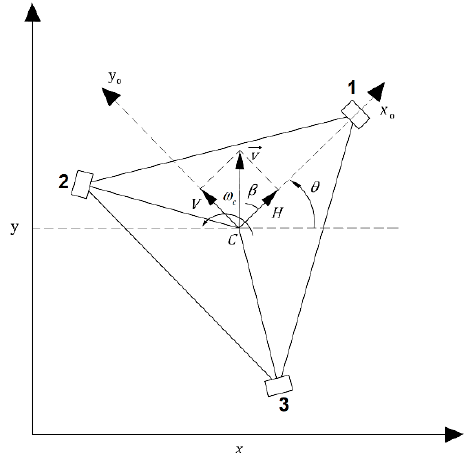
Figure 2. Configuration of velocity vector of the omnidirectional wheeled wheelchair in the body coordinate frame.